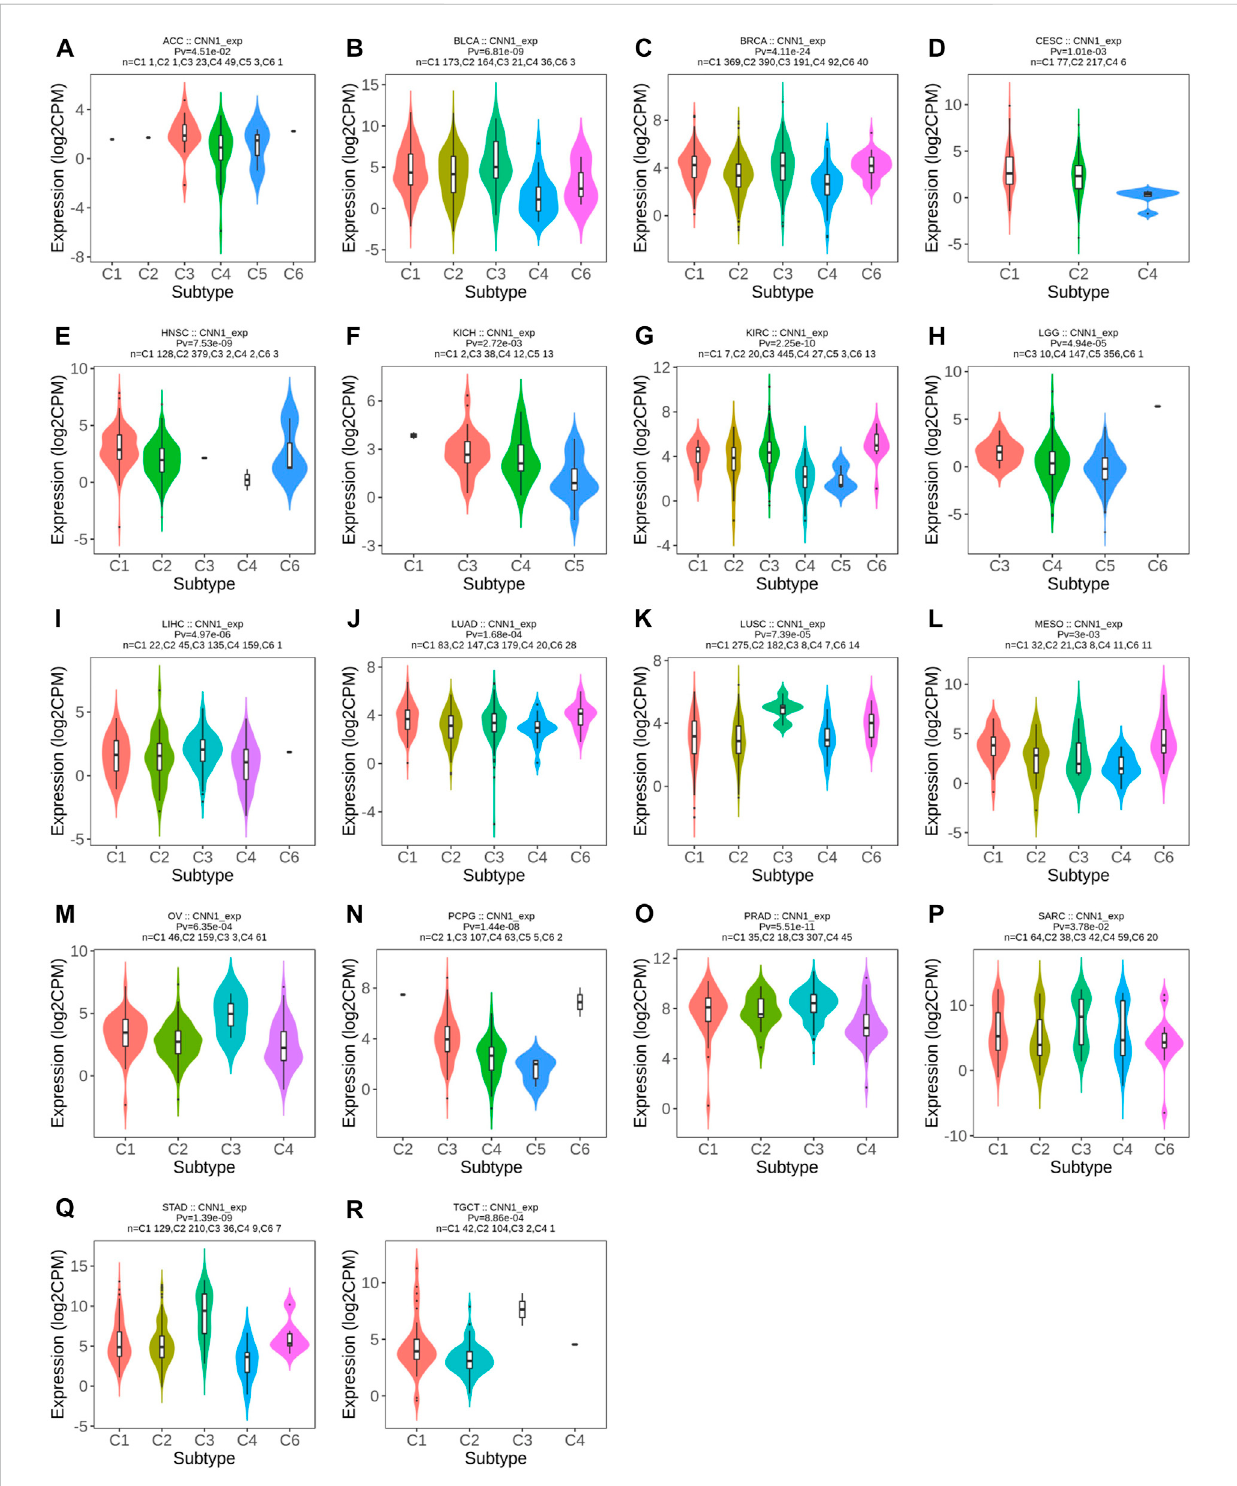
FIGURE 4 Relationship between CNN1 expression and immune subtypes. (A) ACC, (B) BLCA, (C) BRCA, (D) CESC, (E) HNSC, (F) KICH, (G) KIRC, (H) LGG, (I) LIHC, (J) LUAD, (K) LUSC, (L) MESO, (M) OV, (N) PCPG, (O) PRAD, (P) SARC, (Q) STAD, and (R)